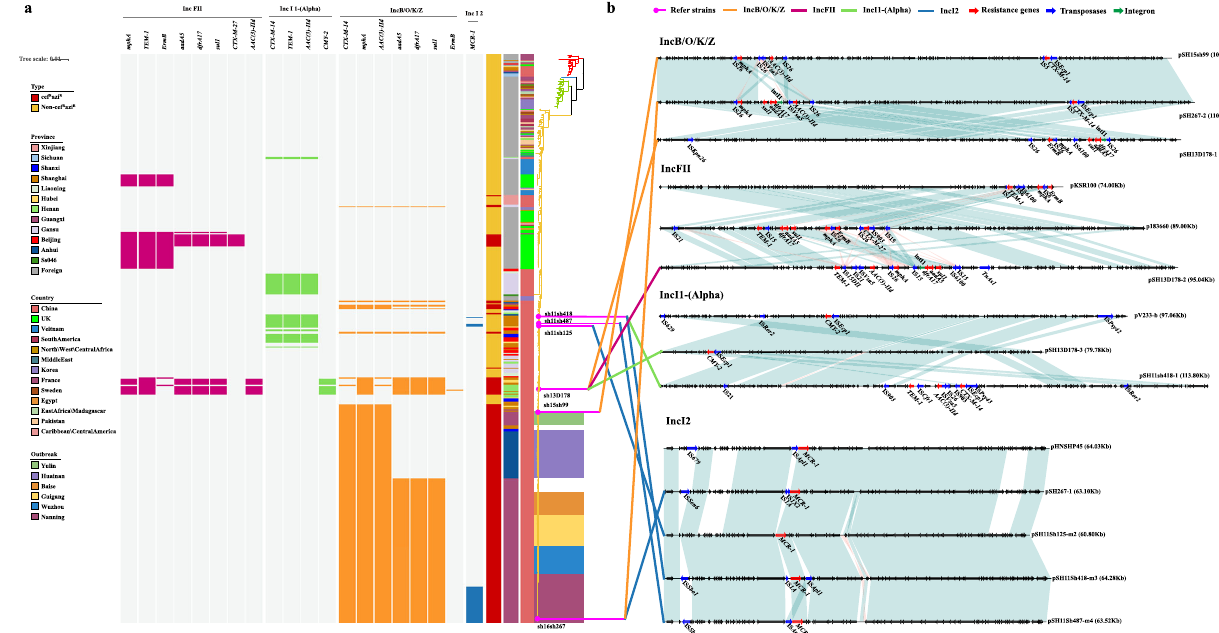
Fig. 4 | Plasmid pro fi les and pairwise comparisons ofplasmids associatedwith the cef R azi R and col R phenotypes. a Plasmids and plasmid-mediated resistance genes are represented in the heatmap by red, green, yellow, and blue bands, respectively. b Pairwise comparisons of the plasmids harboring the bla CTX-M , bla CMY-2 , bla TEM-1 , mphA/ermB , and mcr-1 genes. Four replicons of